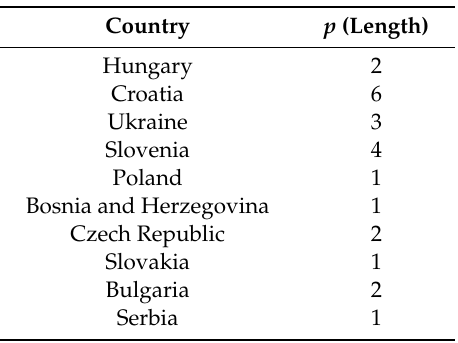
Table 2. VAR ( p ) model details, by